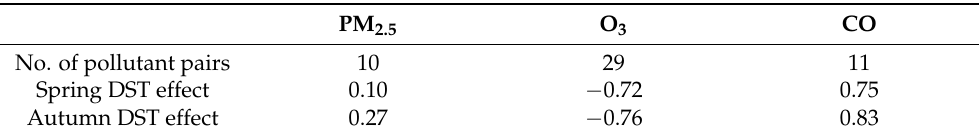
Table 2. Median correlation between the DST effect of NOx and of the other pollutants. NOx is observed at most of the AQM stations in the study area. Its spring and autumn DST effects in each AQM station were correlated with the corresponding DST effects of the other pollutants that were observed at the same AQM station. At least 15 years (10 in the case of CO) of data were required for the AQM station data to be included in the